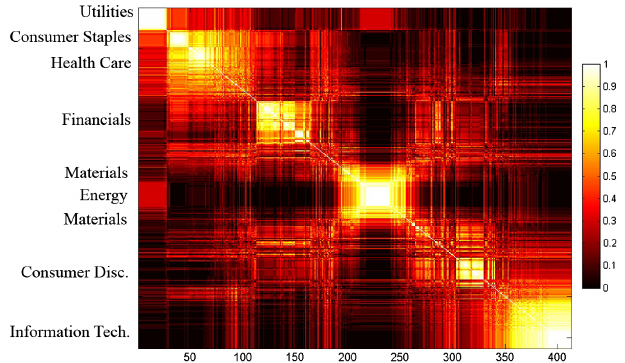
FIG. 21. Coherence of communities over time. The heat map shows the frequency of co-occurrence of different pairs of stocks within the same community over time (white: unit frequency; black: zero frequency). The stocks have been ordered using simulated annealing to position stocks with a high degree of cross-correlations next to each other. To further inform the graph, the GICS sectors have been specified, emphasizing which groupings of stocks tend to associate with a particular sector (produced using the Louvain